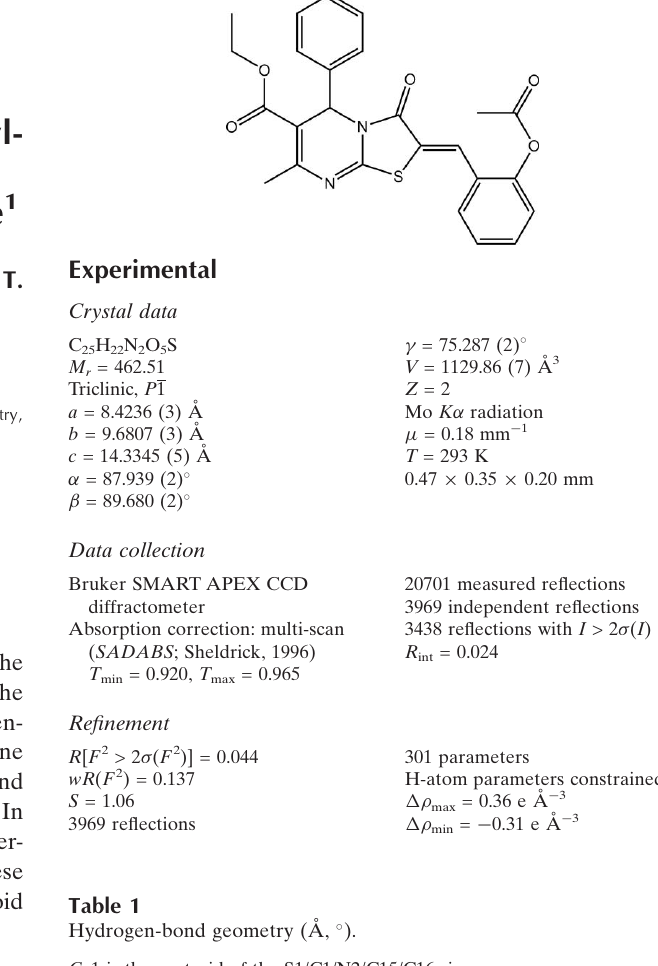
Hydrogen-bond geometry (A˚ , (cid:2)